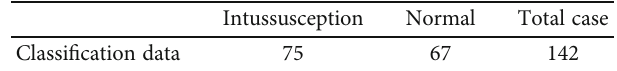
Table 3: Division of classi fi cation data.